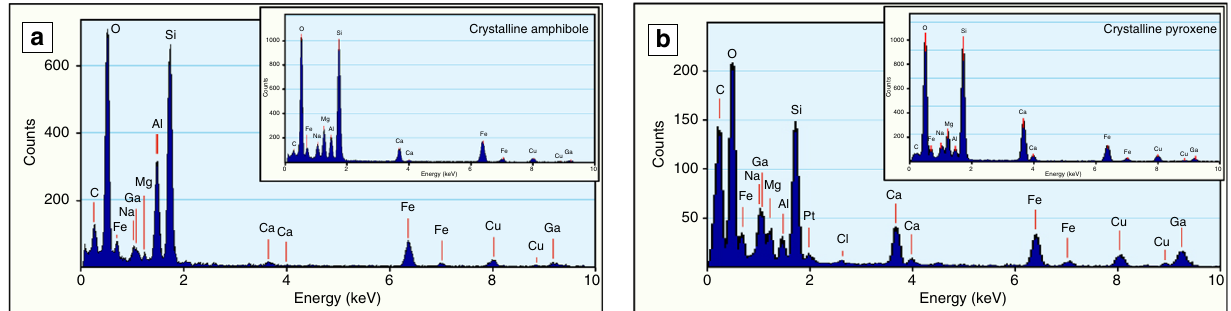
Fig. 5 Comparison of the energy dispersive X-ray spectra of amorphous and crystalline phases. Comparison is of amorphous material resulting from the dissolution of sodic-calcic amphibole ( a ) and cpx ( b ) with their crystalline source minerals (insets). In both amorphous phases signi fi cant amounts of alkalis, Al as well as Fe are present. The expected element transport capacity of these materials is several times larger than that of aqueous solutions. See text for discussion. Ga K and L line intensities are due to Ga ion implantation during FIB milling. Cu K intensity comes from the TEM copper grid. Pt intensity is due to redeposited Pt during FIB